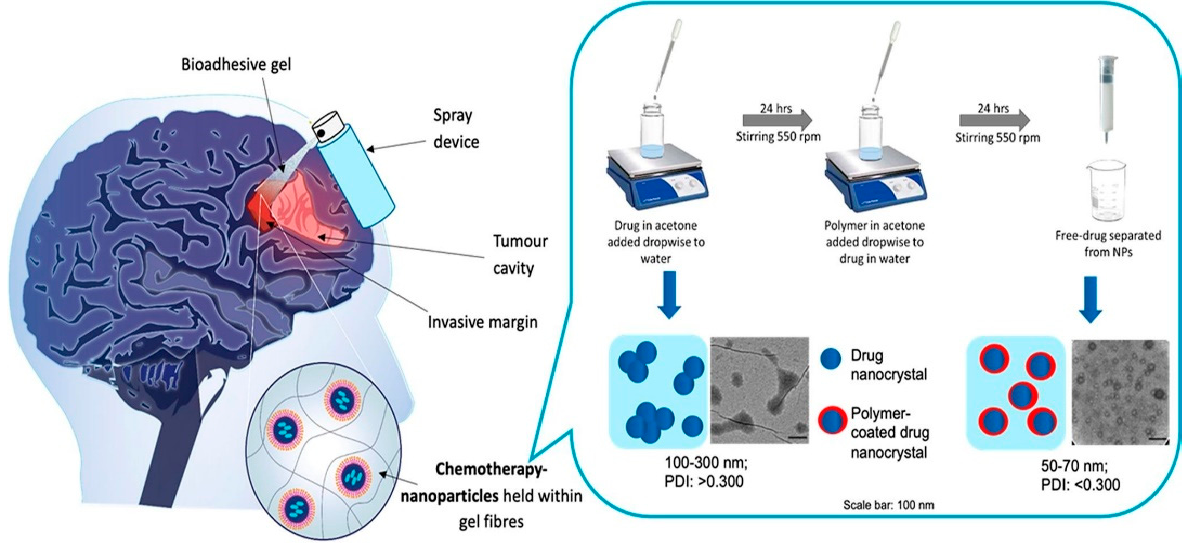
Figure 2. A diagrammatic representation of delivering a PARP inhibitor to glioblastoma cells using a bioadhesive sprayable gel. Reprinted with permission from ref. [113]. Copyright 2020 Elsevier, under a Creative Commons license (CC BY-NC-ND 4.0).